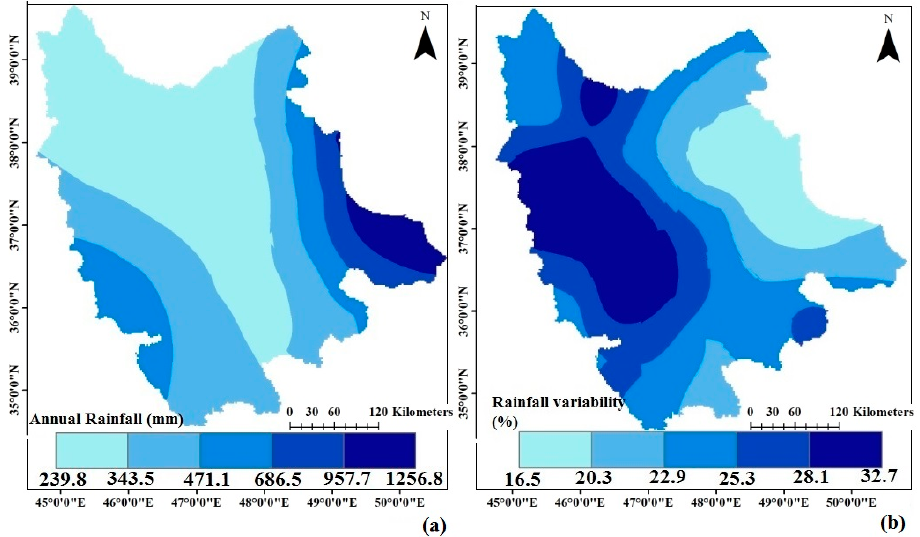
Figure 3. Spatial distribution of ( a ) mean annual rainfall, and ( b ) rainfall variability over the northwestern corner of Iran.